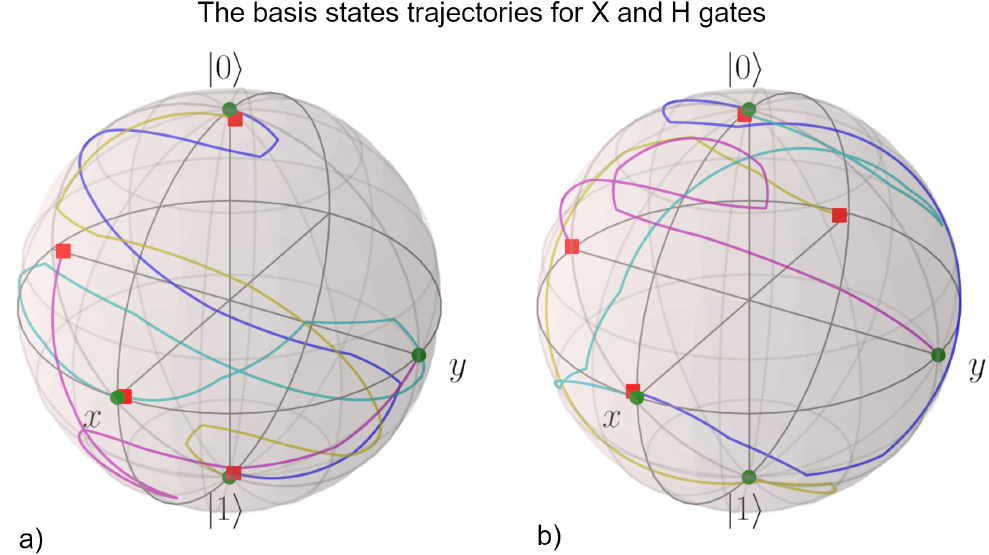
Figure 3. Optimal trajectories of the basis states (15) in the Bloch ball for generation of the quantum gate X (subplot a ) and the Hadamard quantum gate H (subplot b ). Initial states are indicated by green dots, final states by red squares, and target states are centers of the black circles. The trajectories lie close to the Bloch sphere, in the region with a distance of about 0.05 to the